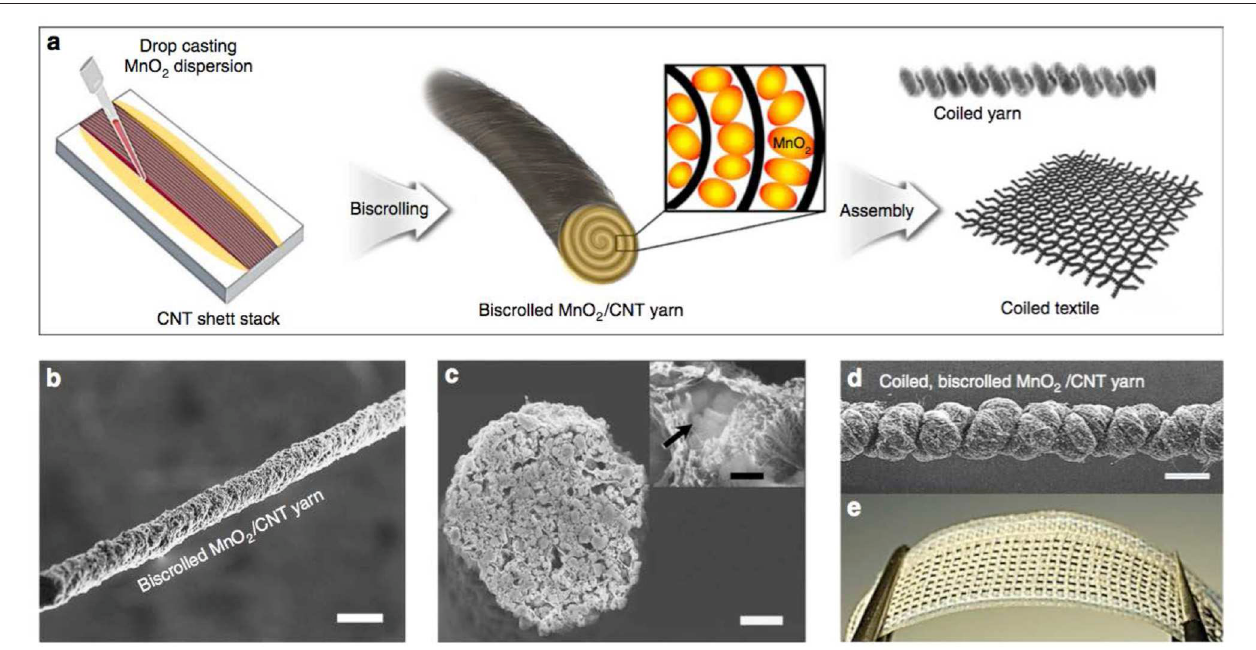
FIGURE 5 | Schematic showing the (a) preparation and structure of biscrolled CNT/MnO 2 hybrid fiber, SEM morphologies of (b,c) as-spun biscrolled hybrid fiber and (d,e) two-ply coiled yarn integrated in a fabric ( Choi et al., 2016).